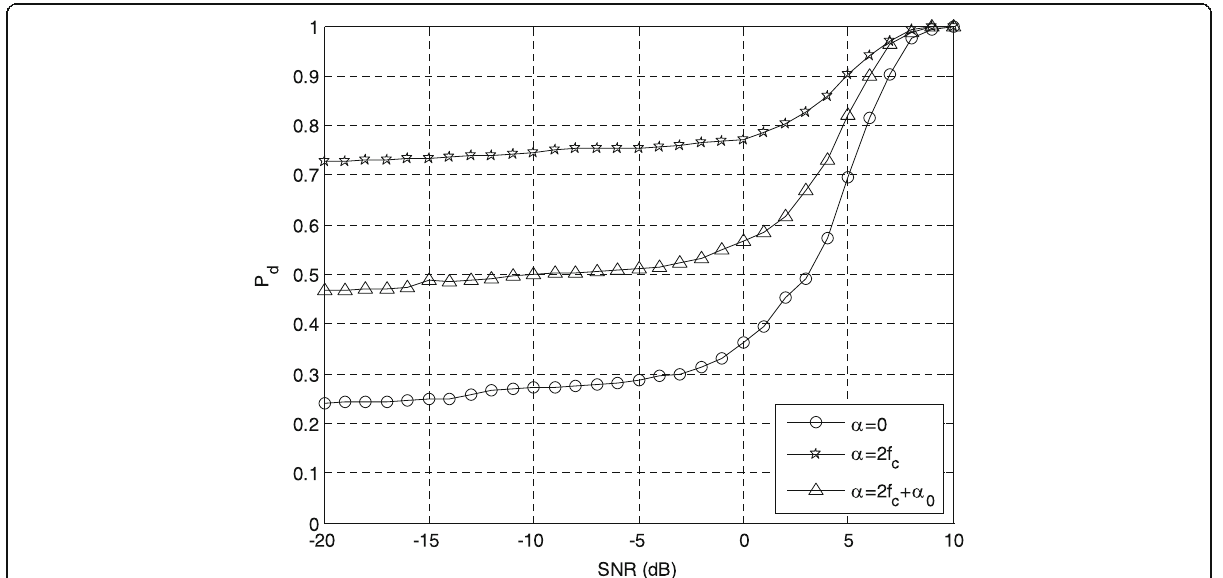
Fig. 5 Comparison of detection performance based on SC method at different cyclic